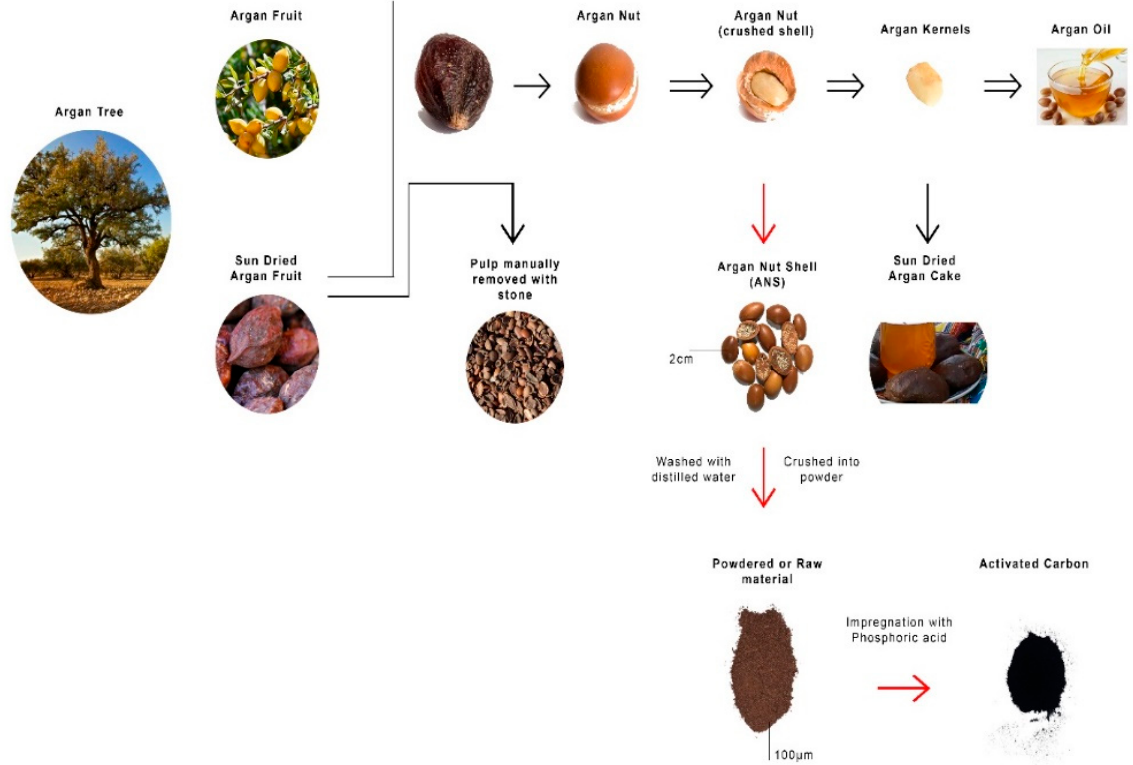
Figure 1. Initial samples of argan fruit and the process of preparation of activated carbon.